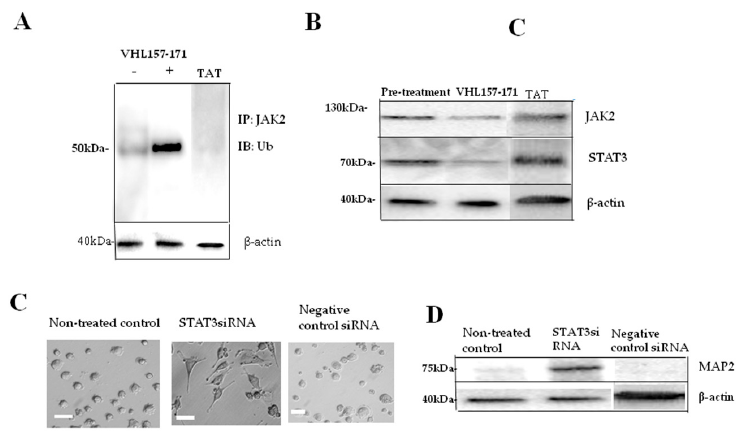
Figure 5. ( A ) Ubiquitination assay. IP with anti-JAK2 followed by immunoblotting (IB) with anti-ubiquitin. VHL(157–171) peptide was added (+) ( center lane ), not ( − ) ( left lane ), or TAT ( right lane ). When VHL(157–171) peptide was added, ubiquitination was significantly enhanced ( p < 0.001); ( B ) Western blotting analysis using anti-JAK2 and anti-STAT3 for cells before and after treatment with VHL(157–171) peptide or TAT alone. Bands for JAK2 and STAT3 were found for pre-treated cells or TAT-treated cells more than post-treated cells ( p < 0.01); ( C ) Morphological study on STAT3 siRNA-treated cells, negative control siRNA-treated cells, and non-treated cells. STAT3 siRNA-treated cells had significantly more neurites than negative control siRNA-treated cells ( p < 0.01) or non-treated cells ( p < 0.01). Scale bar = 20 μ m; ( D ) Western blotting analysis using anti-MAP2 antibody for STAT3 siRNA-treated cells, negative control siRNA-treated cells, and non-treated cells. A significantly more distinct band was found for STAT3 siRNA-treated cells than negative control siRNA-treated cells ( p < 0.01) or non-treated cells ( p < 0.01).